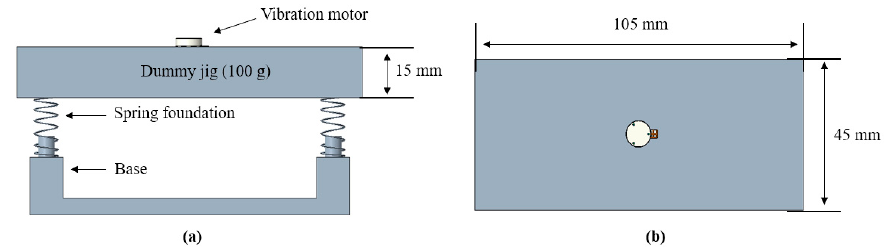
Table 1. Mechanical properties of the linear vibration motor.